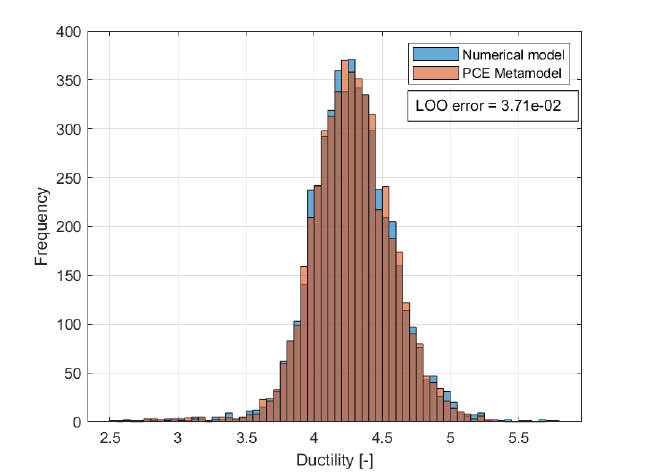
Figure 13. Histogram of 500 samples of ductility factor values obtained using the numerical model and PCE metamodel.